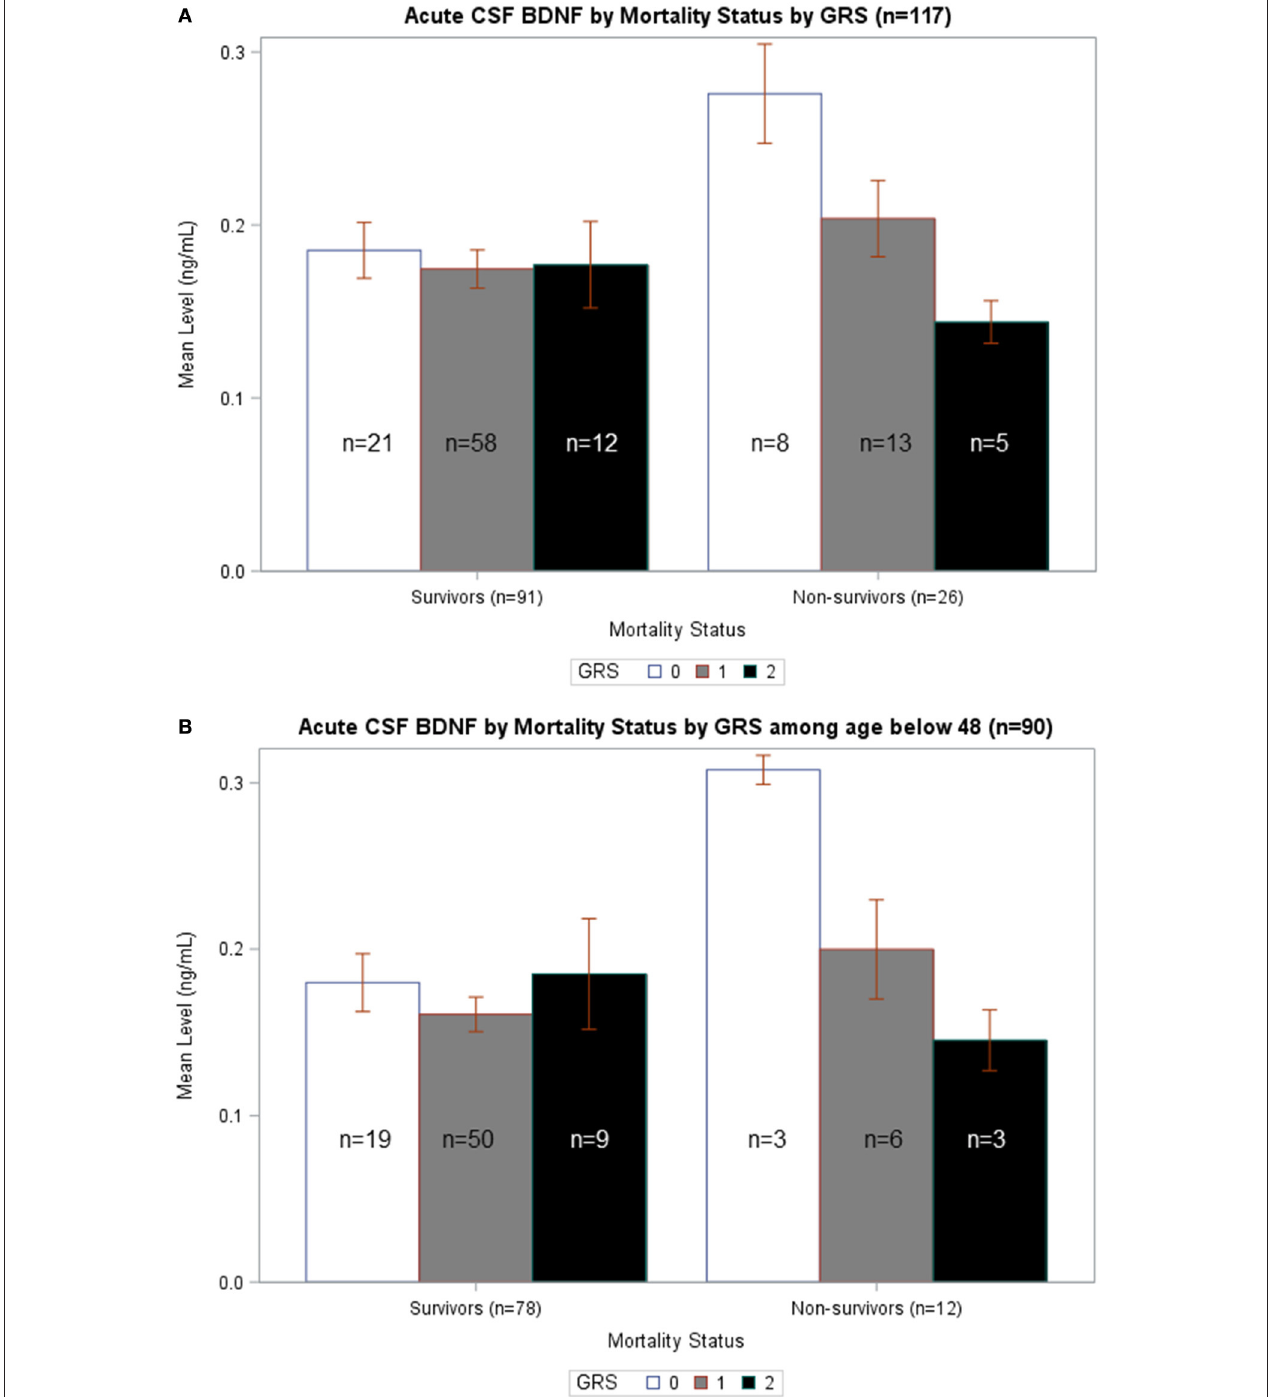
FIGURE 5 | (A) Acute CSF BDNF by Mortality Status by GRS. Weekly average CSF BDNF (ng/mL) is reported. Error bars indicate standard error of the mean. White, gray, and black corresponds to GRS scores of 0, 1, and 2, respectively. Results are stratified among survivors ( n = 91) and non-survivors ( n = 26). Among non-survivors, there is a significant difference in BDNF levels by GRS, such that higher GRS scores have lowest BDNF levels ( p = 0.015). There is no difference in BDNF levels by GRS in survivors-only. Only among individuals with GRS scores of 0 is there a significant difference in BDNF levels in survivors compared to non-survivors ( p = 0.007). (B) Acute CSF BDNF by Mortality Status by GRS among age below 48. Weekly average CSF BDNF (ng/mL) in reported after restricting population to only individuals below age 48. Error bars indicate standard error of the mean. White, gray, and black corresponds to GRS scores of 0, 1, and